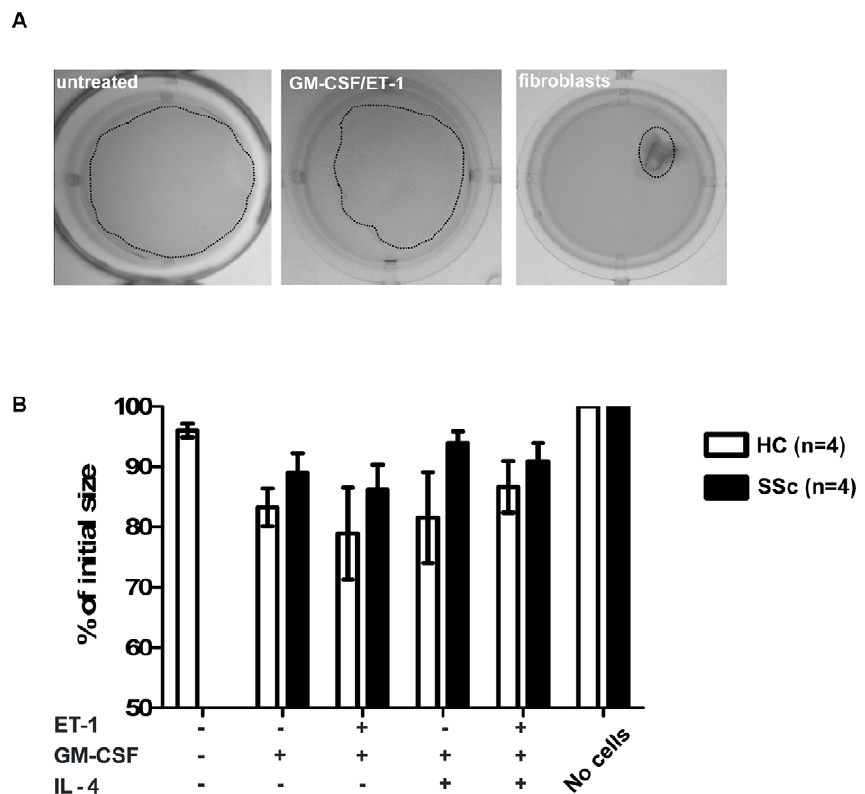
Figure 4. GM-CSF treated monocytes are partially contractile. 5 6 10 6 CD14 + monocytes from SSc patients or healthy controls were seeded on collagen gels and cultured for 14 days under different conditions as indicated. On day 14, the reduction of the gel area was calculated as percent of the initial seize. B) The graph shows the summary of data from 4 healthy controls and 4 SSc patients. A significant difference between the two groups was not